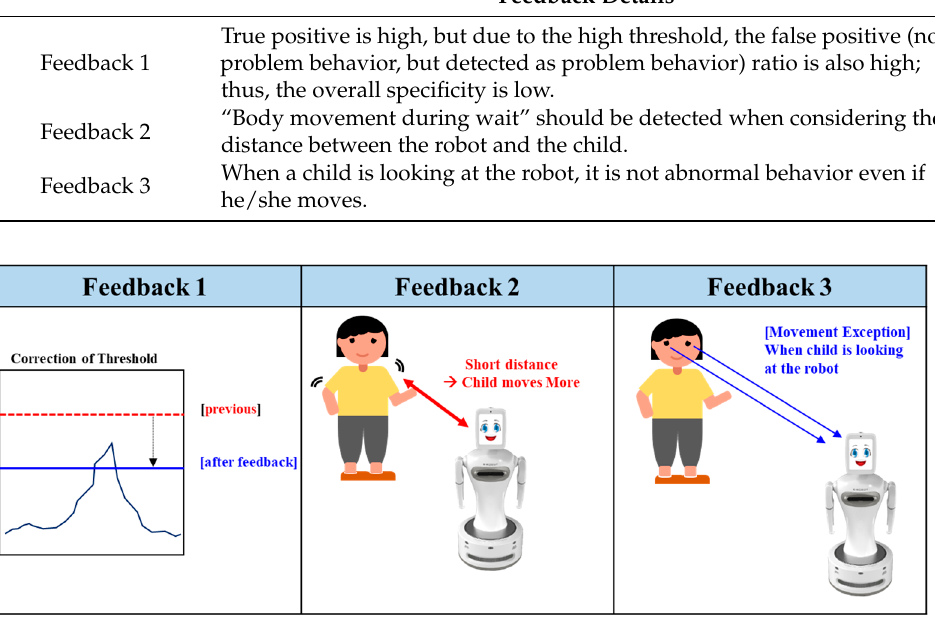
Table 4. Feedback result of the video-labeling review.